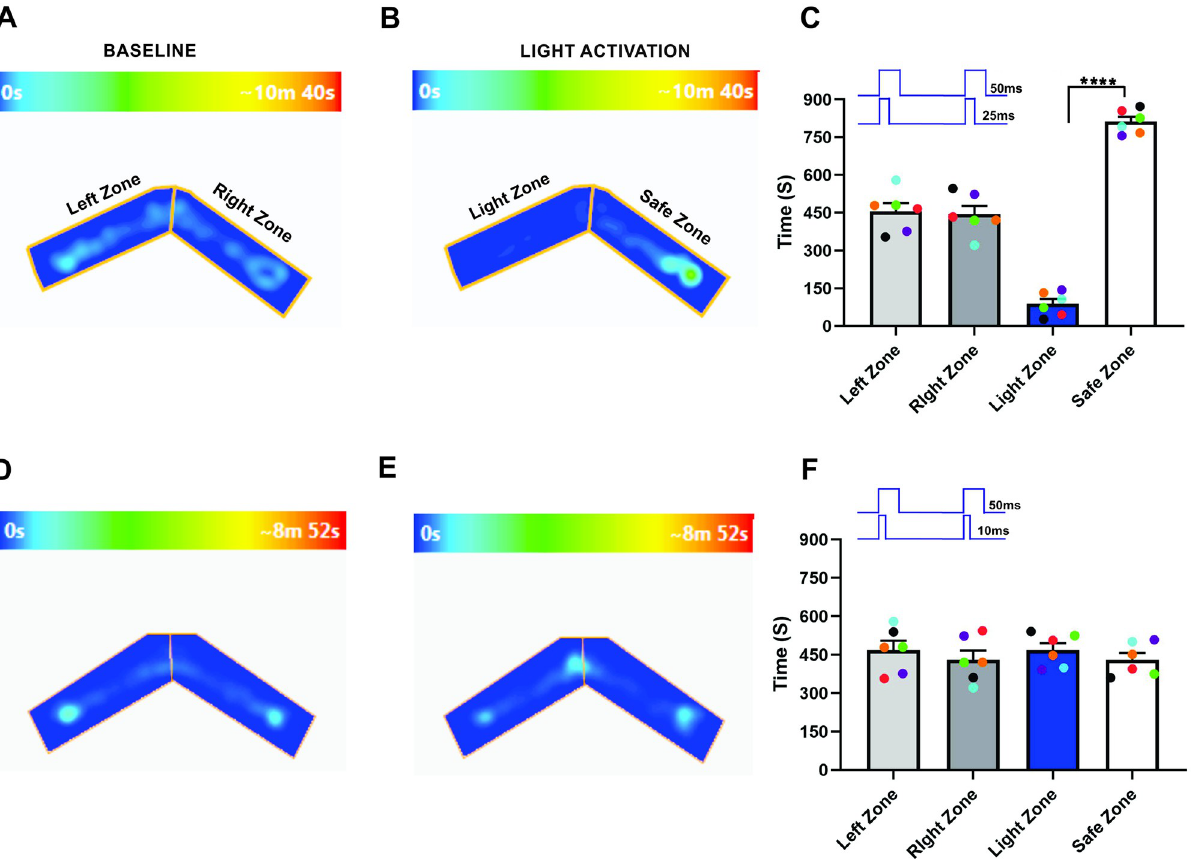
Fig 4. Stimulus duration influences the bilateral olfactory information. A, B, an example of heat-map showing the animal’s position in the “two- arms maze” during baseline (A) and dual OB (50–25 ms) light stimulation (B). C, Average amount of time explored in each zone in baseline and dual OB (50–25 ms) light stimulation trials. D, E, Heat-map of mouse position during baseline (D) and dual OB (50–10 ms) light stimulation (E). F, Average amount of time spent in each zone in baseline and dual OB (50–10 ms) light stimulation trials. ( ���� P < 0.0001, n = 6